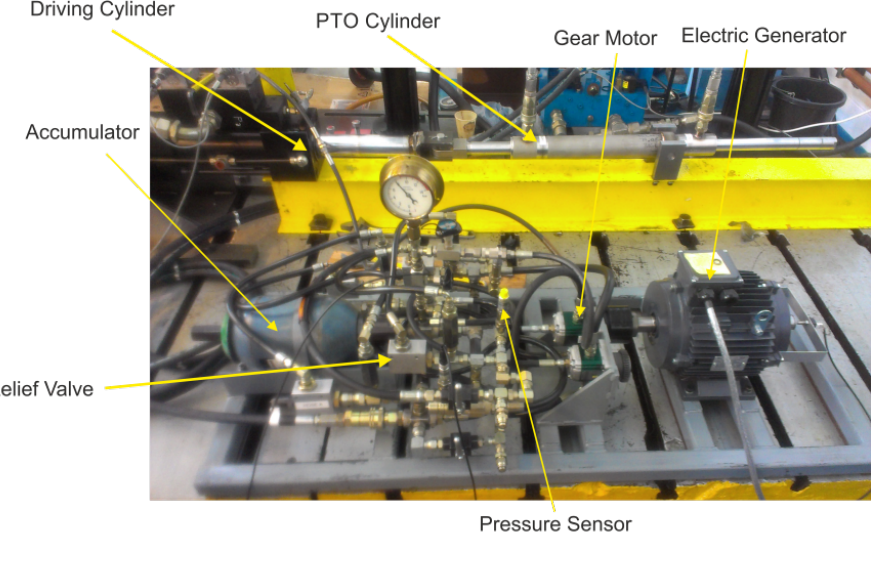
Figure 11. Variable pressure test